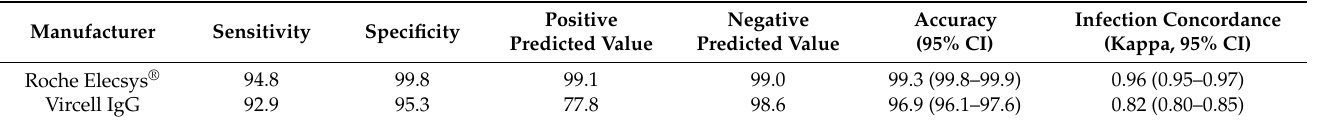
Table 4. Immunoassay performed to diagnose previous SARS-CoV-2 infection in the study cohort ( n =